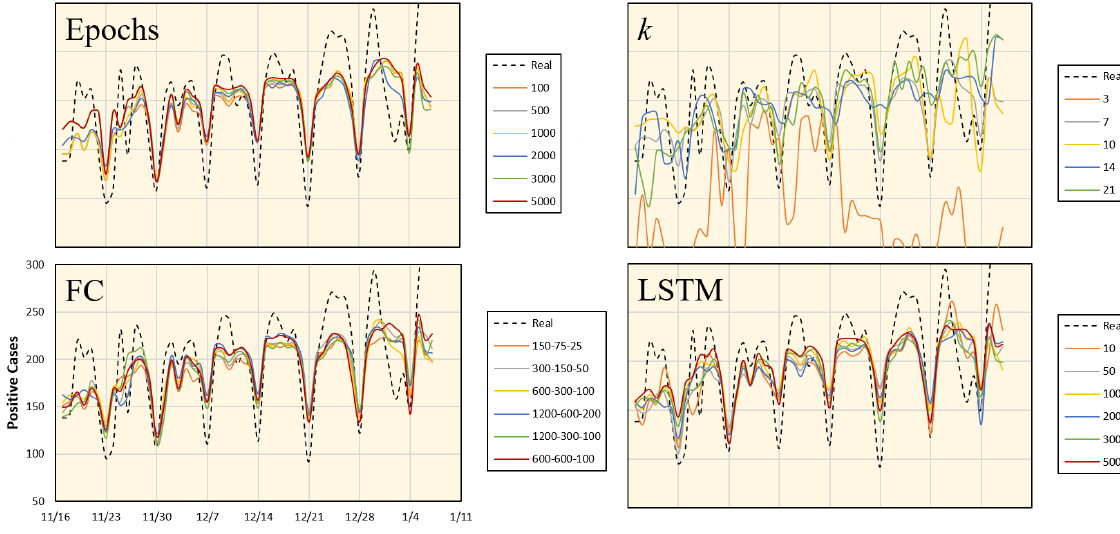
Figure 10. Number of positive cases estimated for the Aichi prefecture using different parameter